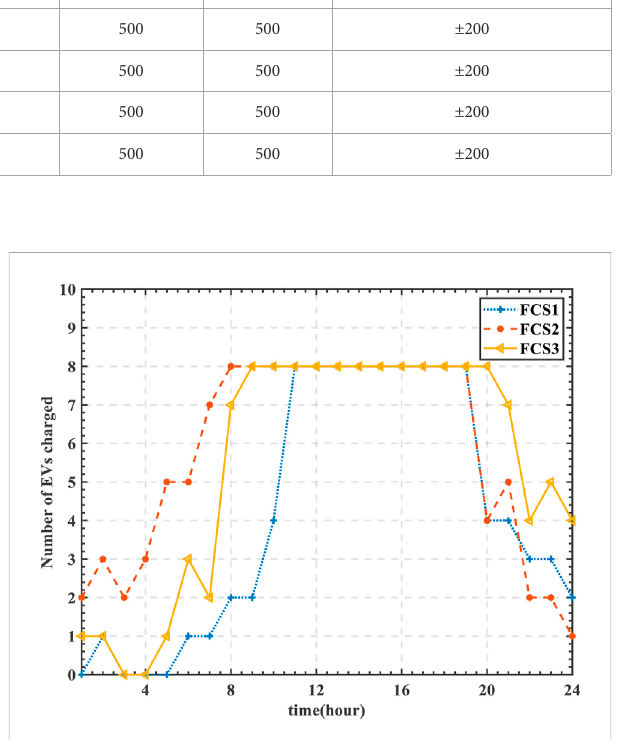
FIGURE 5 TOU setting.